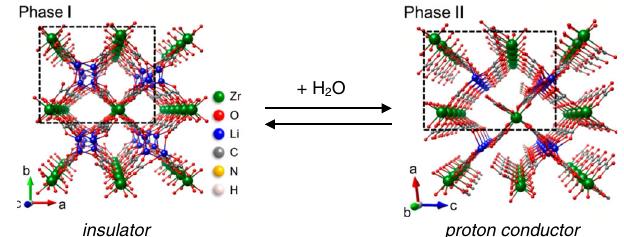
Fig. 1 Structural change of a metal – organic framework upon water adsorption. A proton-conducting phase, owing to a hydrogen-bonded chain of water molecules, forms in the pores of the MOF ((CH 3 ) 2 NH 2 ) 2 [Li 2 Zr (C 2 O 4 ) 4 ] upon water adsorption. Reprinted with permission from ref.